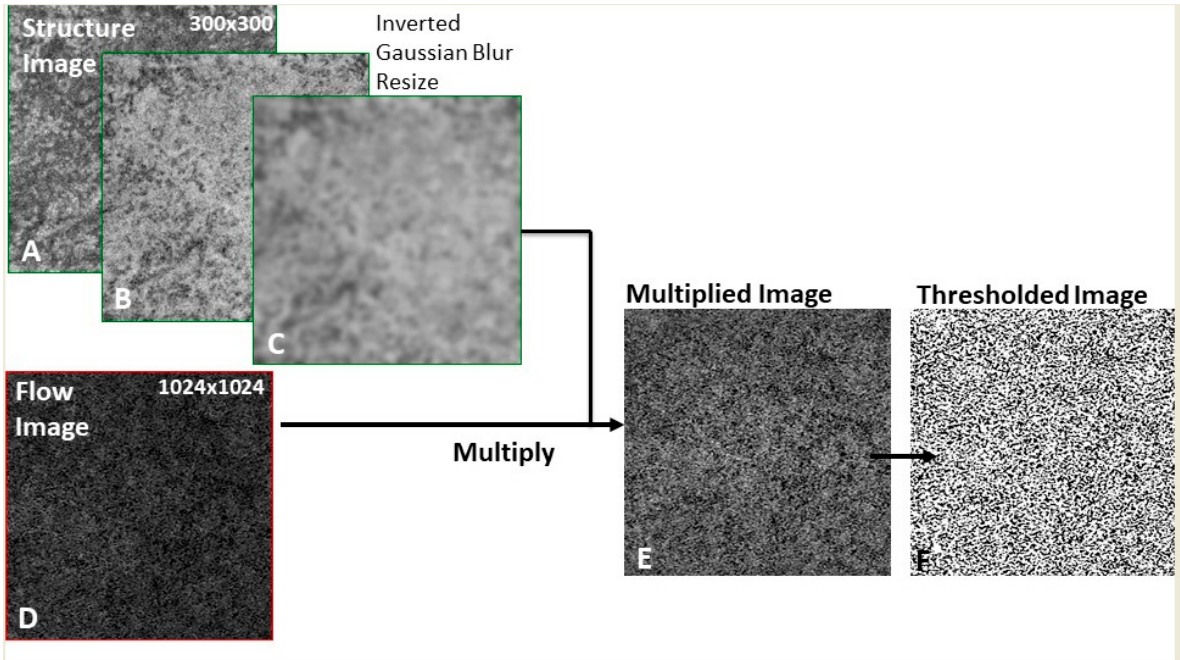
Figure 1. Representation of the algorithm used to investigate the choriocapillaris (CC). To the en face CC structure image ( A ) an inverse transformation was applied using the Fiji “Invert” function ( B ). Smoothing was obtained using the Gaussian blur filter ( C ). Multiplication between the en face CC flow image ( D ) and the processed en face CC structure image ( C ) was performed using “Image Calculator”. A compensated en face CC image was obtained ( E ). Binarization of the compensated en face CC flow image was performed using the Phansalkar threshold (radius: 15 pixels) in order to obtain a quantitative analysis of the flow deficits as described in recent literature ( F ).